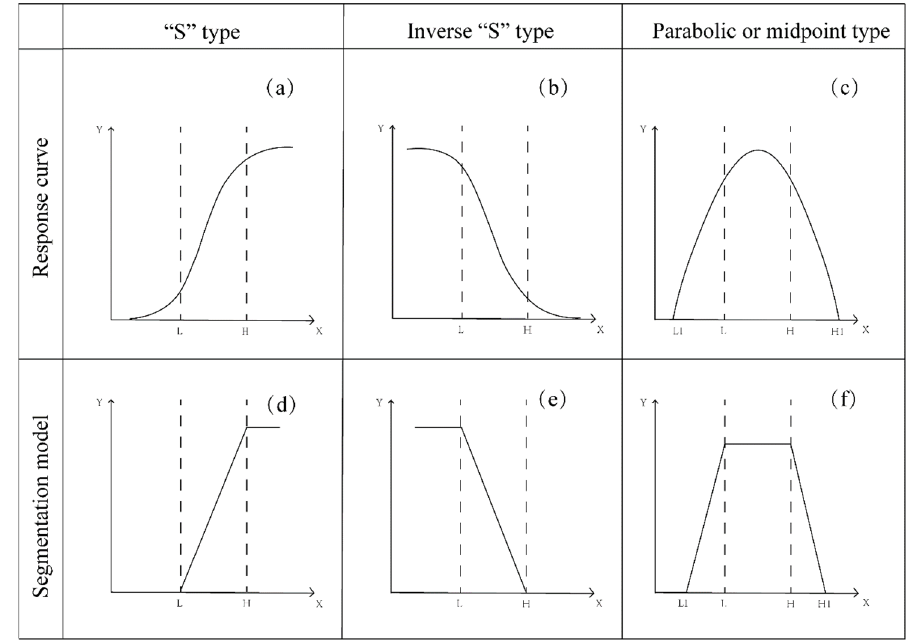
Figure 4. Three types of evaluation models: (a) “S” type response curve, (b) inverse “S” type response curve, (c) parabolic or midpoint type response curve, (d) “S” type segmentation model, (e) inverse “S” type segmentation model, (f) parabolic or midpoint type segmentation model. Table 6. Different evaluation indicators and applicable response curve models.